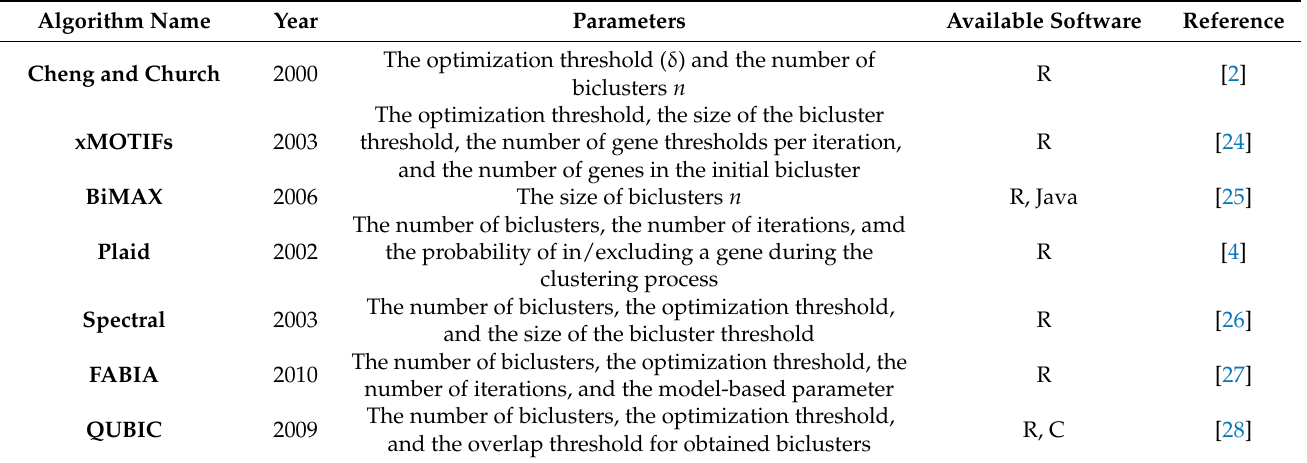
Table 2. Biclustering algorithms and their parameters